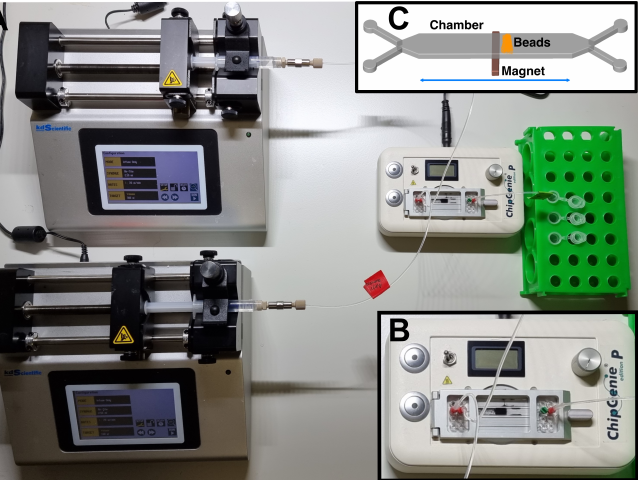
Figure 1. The purification system. Panel ( A ): two motorized syringes are feeding 4-chamber PMMA chips mounted on a “ChipGenie P” device (magnification in panel ( B )) where a magnet can move the microbeads present inside the chambers (scheme of working principle in panel ( C )).